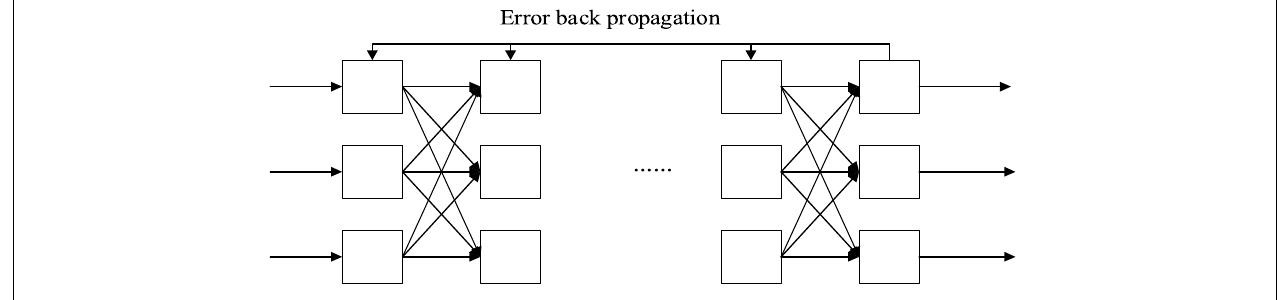
FIGURE 4 | Structure of multilayer error backpropagation NN.